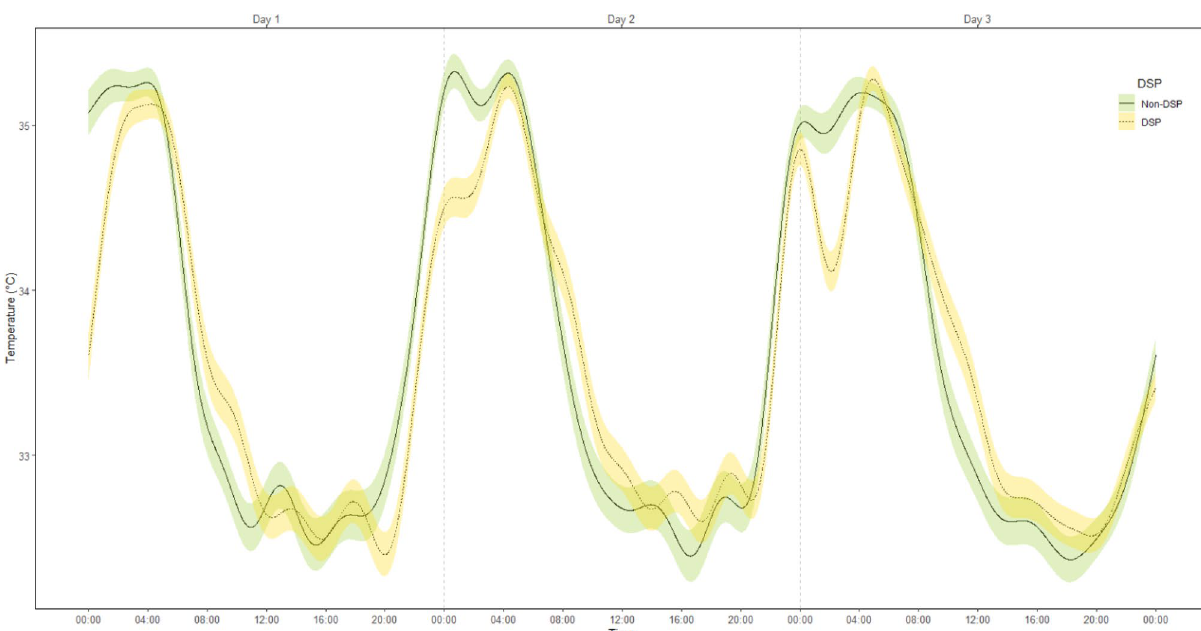
Figure 4. Means, and confidence intervals of original temperature measures in individuals with DSP characteristics and without. Confidence intervals: ± 1 Standard error. Figure produced using R Core Team (2021). R: A language and environment for statistical computing. R Foundation for Statistical Computing, Vienna, Austria. https:// www.R- proje ct.